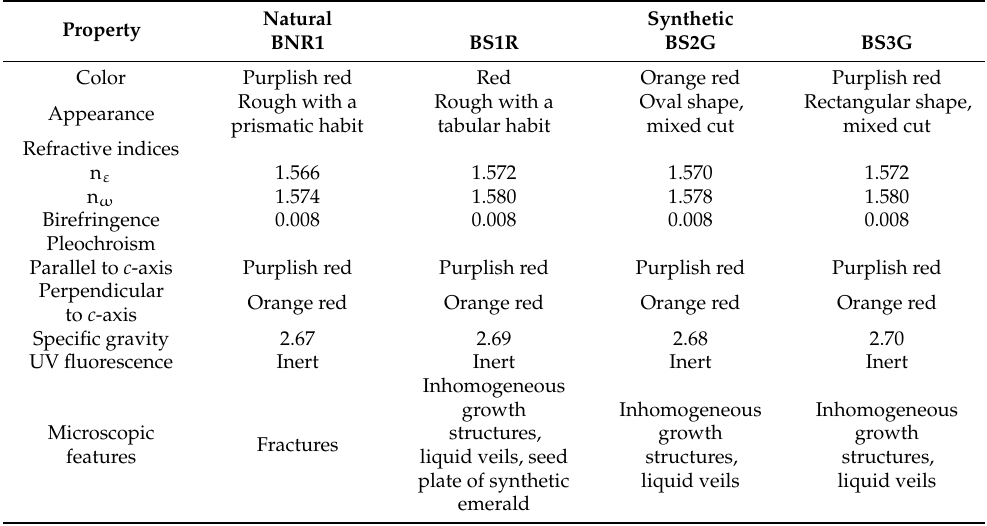
Table 1. Gemmological properties of the hydrothermal synthetic and natural red beryls of this study.